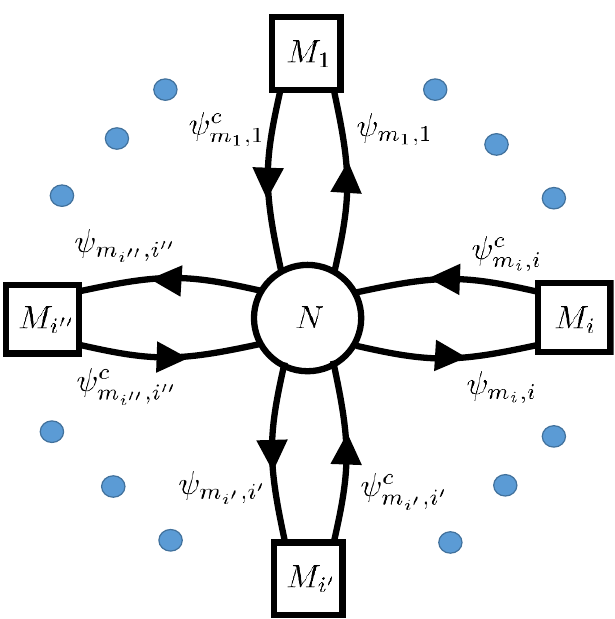
Figure 2 . Depiction of the star shaped quiver generated by an intersecting brane con(cid:12)guration in F-theory. The central node corresponds to the contribution from the 7-brane wrapped over the gauge theory curve, and the satellite nodes indicated as squares correspond to the (cid:13)avor branes of the system. These intersect the Hitchin system curve at points, and for k such intersecting (cid:12)elds, there are regions in the moduli space which are represented by higher poles in the Hitchin system Higgs (cid:12)eld. Each such satellite node corresponds to the location of a distinct marked